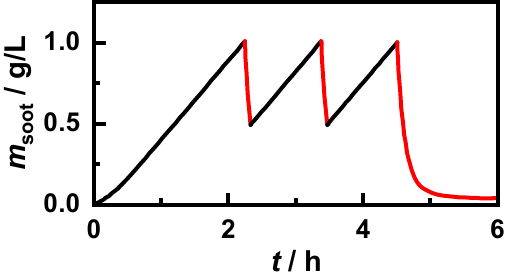
Figure 7. Stored soot mass with the “120 km / h, λ = 1” soot. After reaching 1 g / L, regeneration (marked in red) was initiated by adding 2 vol.% O 2 until 0.5 g / L remained on the filter. After the third loading, permanent lean exhaust gas was present.